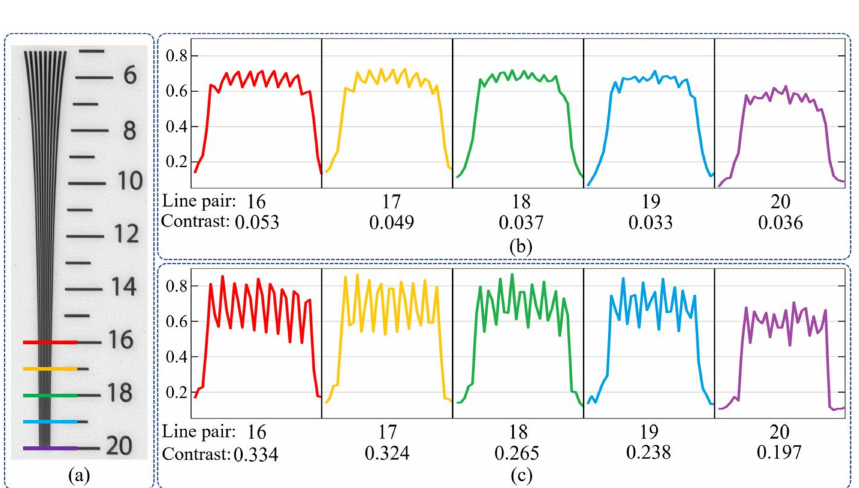
Figure 16. Sections of different lines. ( a ) The wedge lines area of our reconstructed result. ( b ) Profile curves of the processed circular aperture image at lines marked in ( a ). ( c ) Profile curves of our result at lines marked in ( a ).